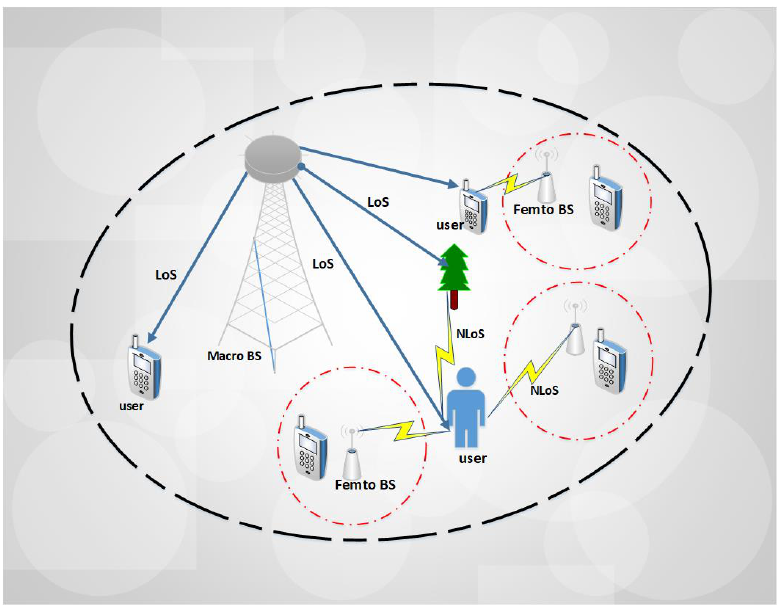
Figure 2. Design of a two-tier HetNet with transmission